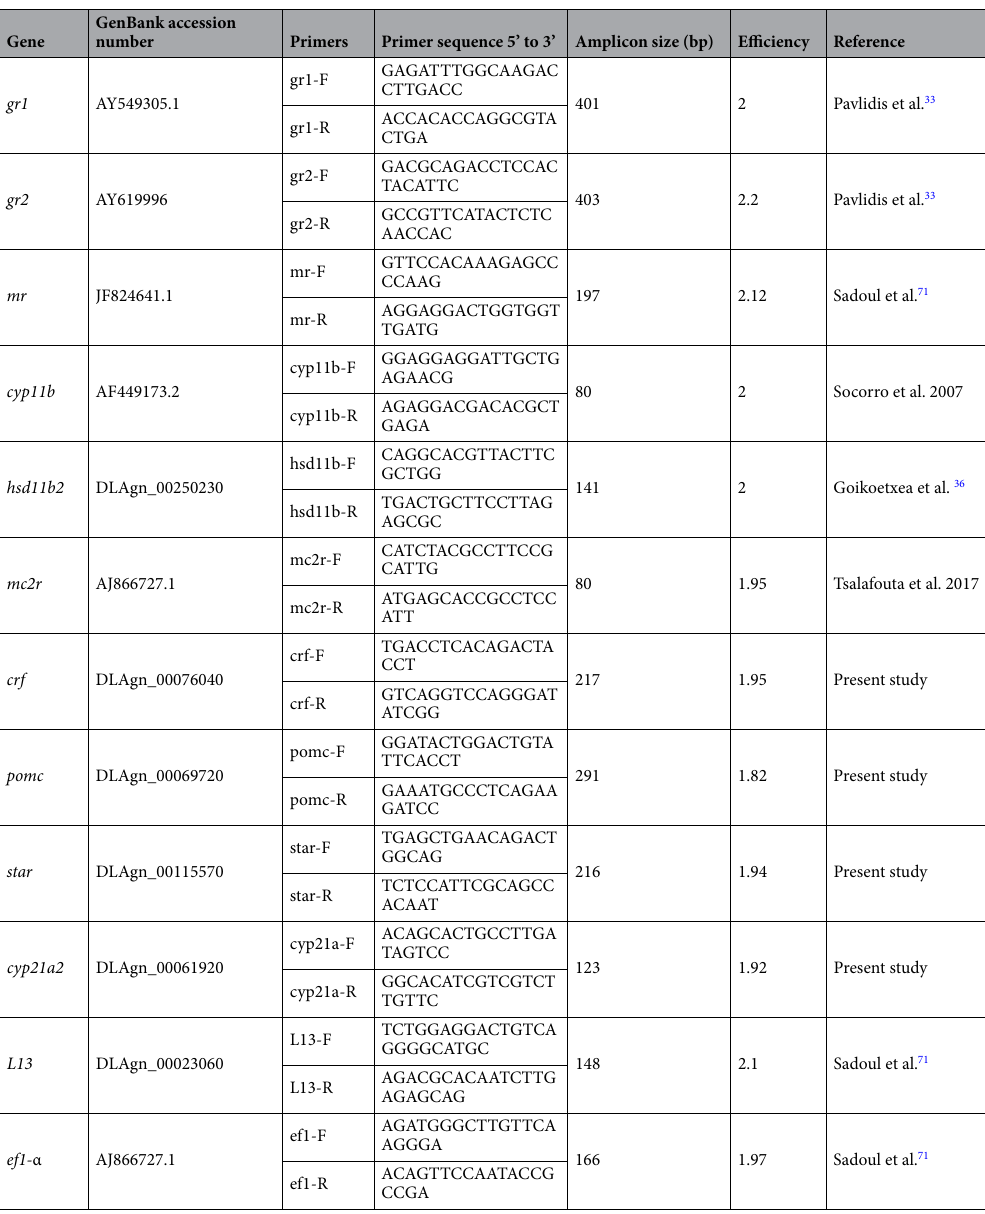
Table 1. Primer sequence, amplicon size and efficiency of all genes used in the